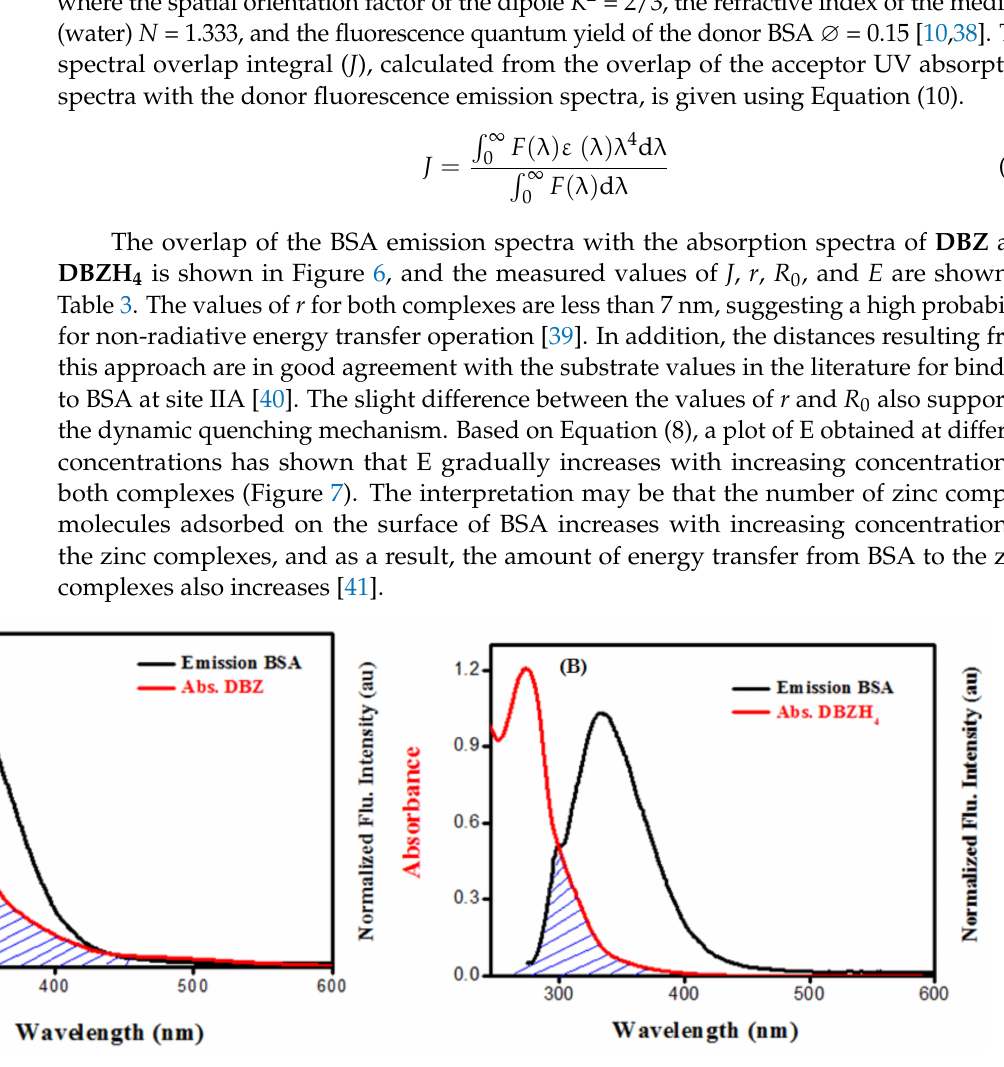
Figure 6. ( A ) Spectral overlap of the fluorescence spectrum of BSA with the absorption spectrum of DBZ ; ( B ) spectral overlap of the fluorescence spectrum of BSA with the absorption spectrum of DBZH 4 , T = 298 K. Table 3. The efficiency of energy transfer, overlap integral, and the distance parameters for DBZ – BSA and DBZH 4 – BSA